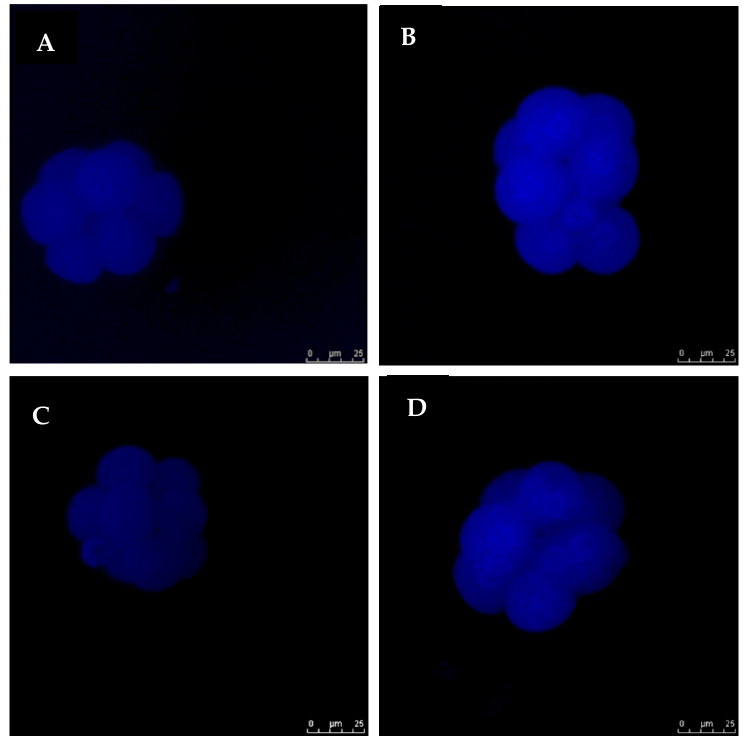
Figure 5. Fluorescent photomicrograph of embryos showing intracellular GSH contents. Images are viewed under 40× magnification. ( A ): Embryo from Group 1 (GSH-free medium); ( B ): embryo from Group 2 (GSH-supplemented medium); ( C ): embryo from Group 3 (GSH-free medium with vitrification); ( D ): embryo from Group 4 (GSH-supplemented medium with vitrification).